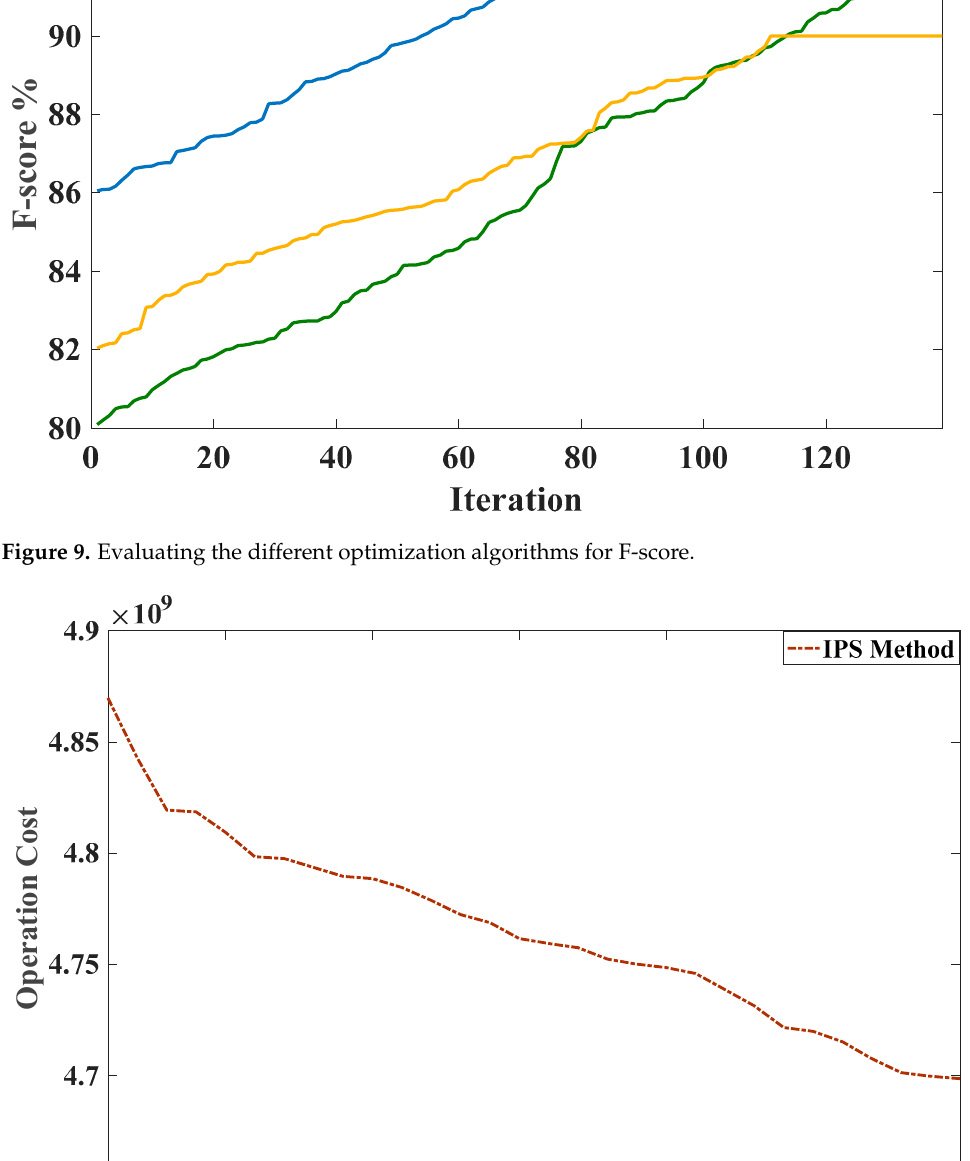
Figure 10. Convergence process of the IPS algorithm.